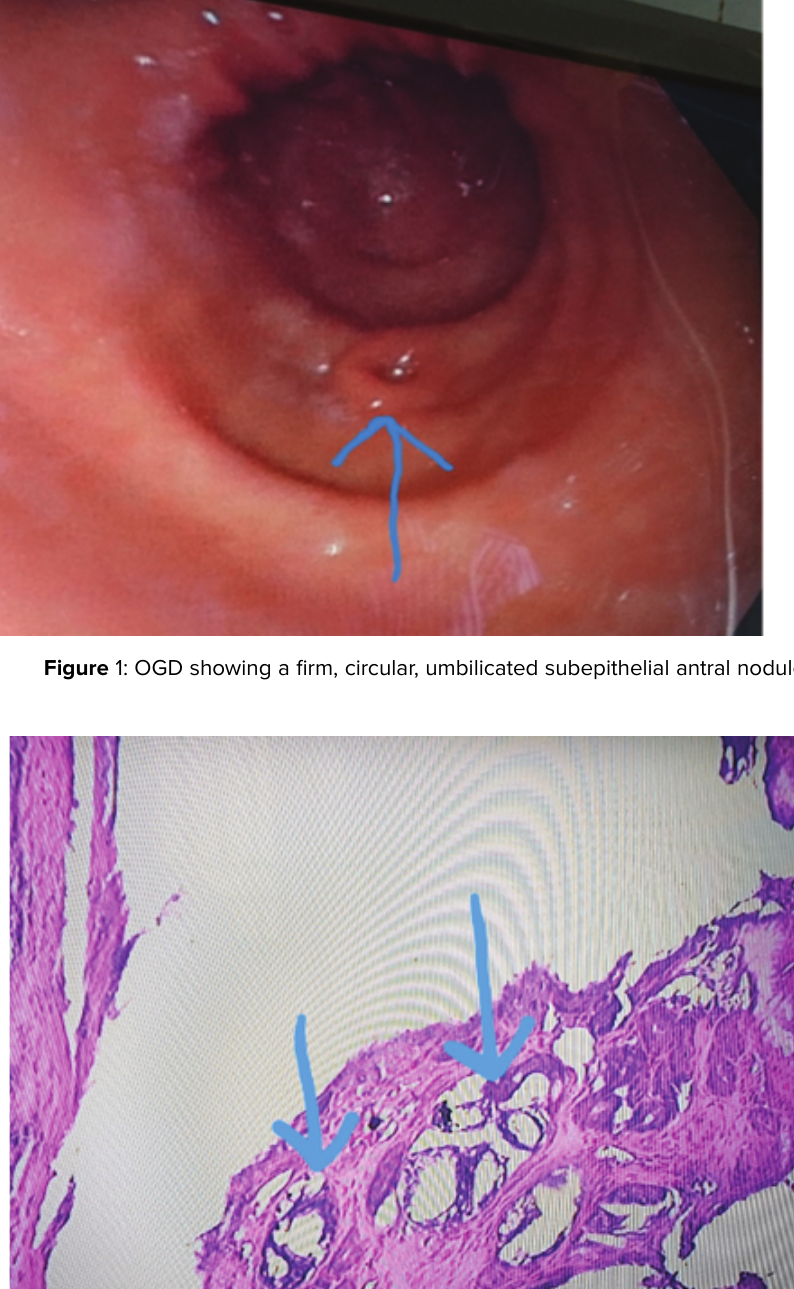
DOI 10.18502/sjms.v15i2.6579